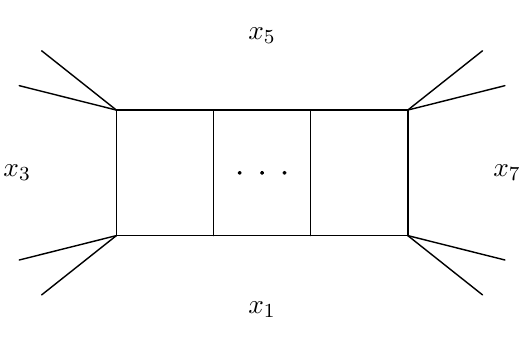
Figure 1 . The eight- or higher-point L -loop ladder integral, labelled by dual